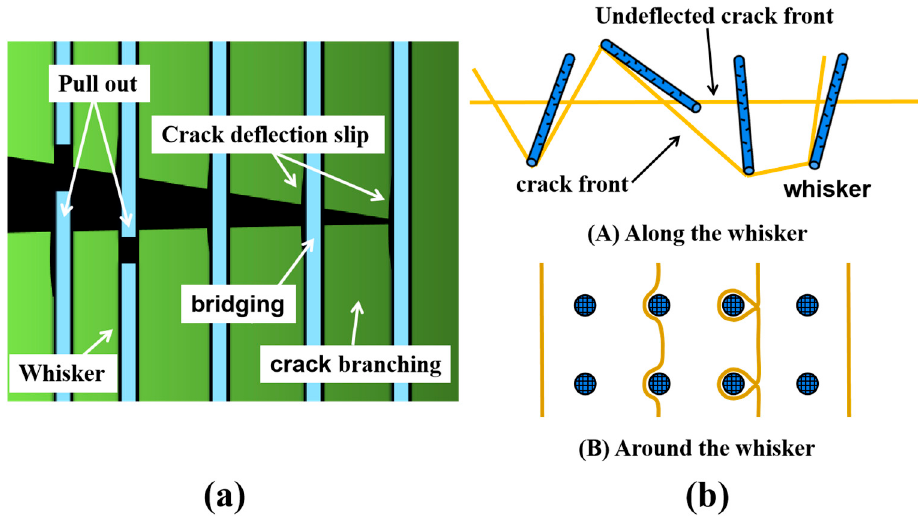
Figure 10. Whisker toughening mechanism ( a ) pull-out and bridging, ( b ) crack deflection.